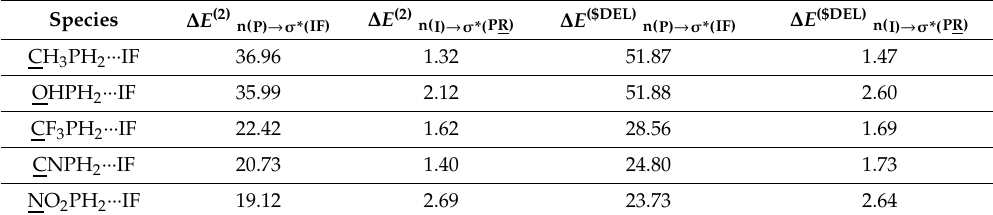
Table 3. ∆ E n σ * stabilization energy estimates(kcal / mol) for halogen-type [ n (P) → σ *(IF)] and